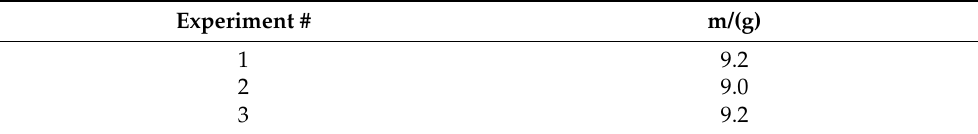
Table 3. Mass of isolated solid fraction after neutral hydrolysis of PET foil coated with chitosan.